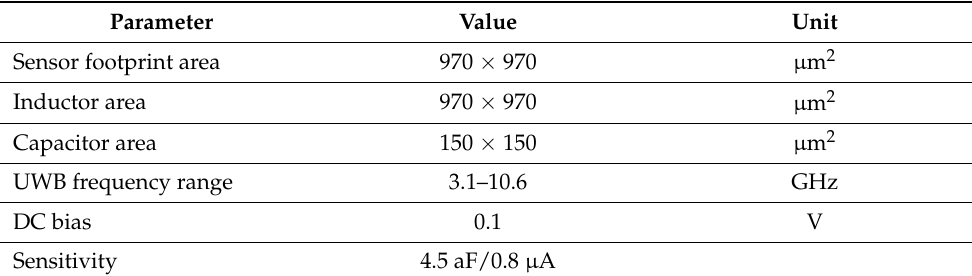
Table 1. MEMS UWB power sensor final specifications.